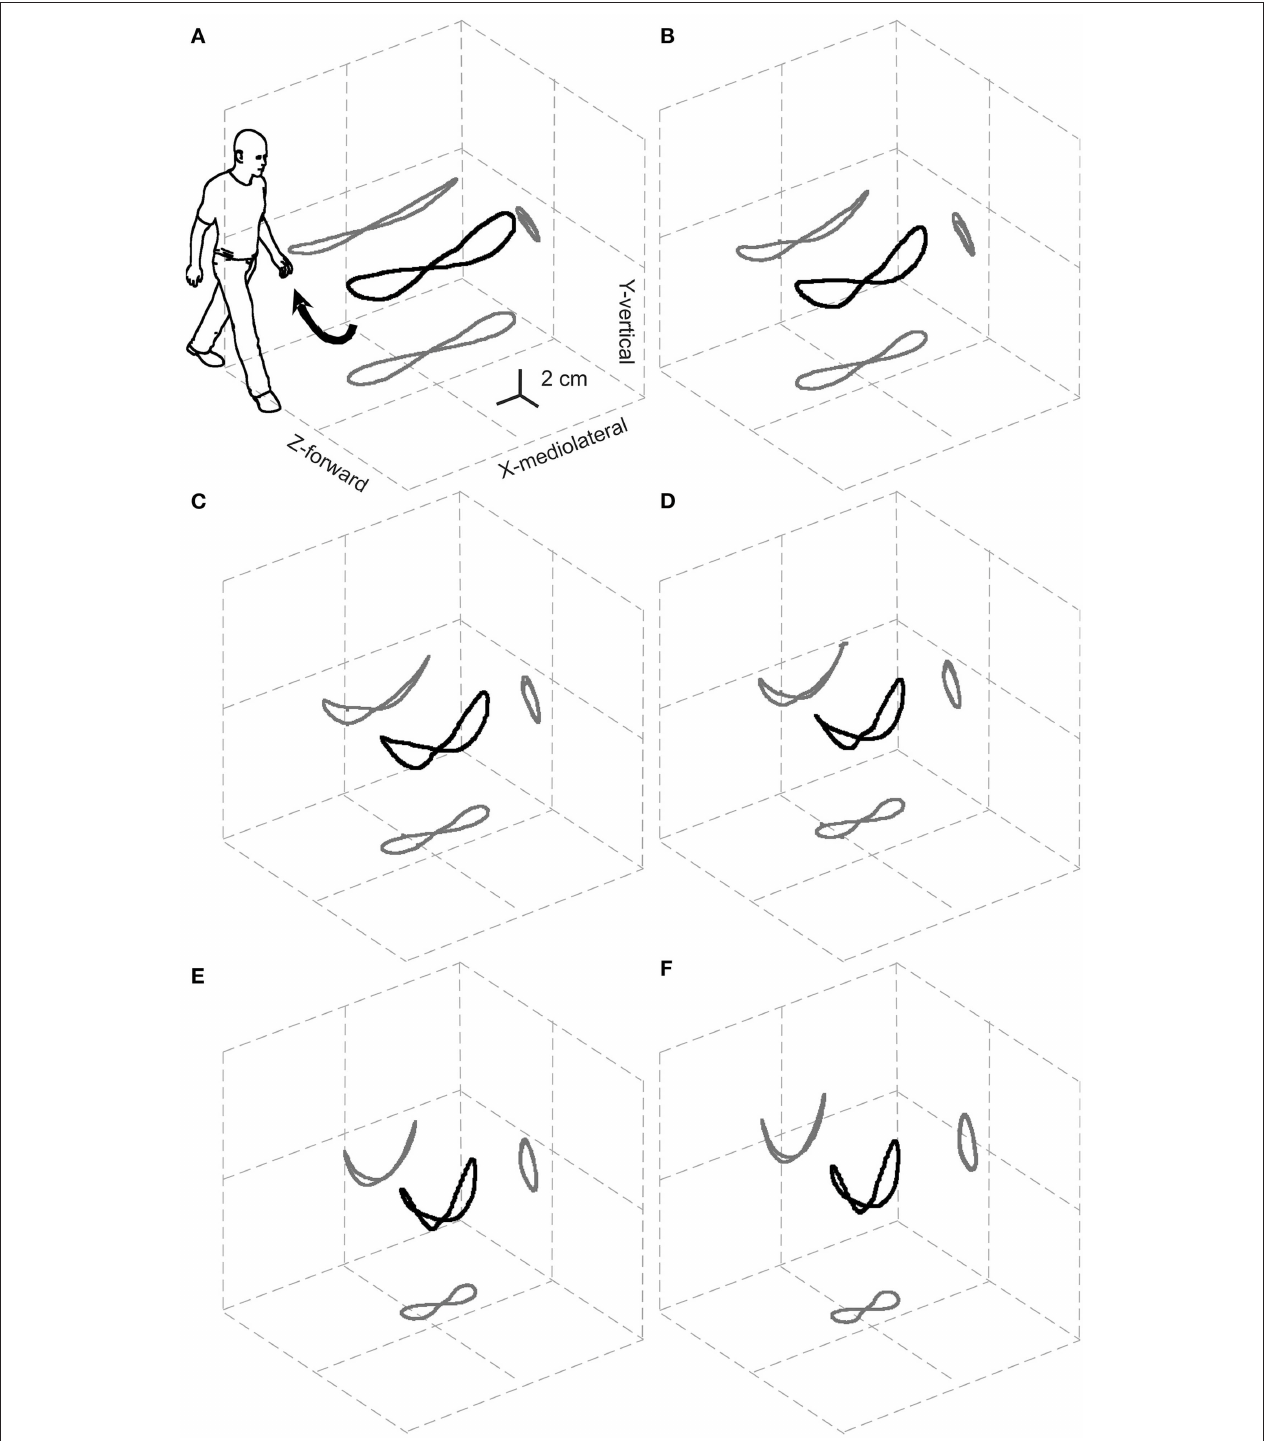
FIGURE 2 | Relationships between the 3D path of the center of mass (CoM) during one stride and the walking speed. The black and gray curves represent the 3D path of the CoM and their planar projections, respectively, once the displacement due to the forward velocity has been subtracted. Results are grand-averaged across 18 subjects. The resulting elegant figure is dubbed the “bow-tie.” The range of speeds tested, illustrated in (A–F) , was partitioned into increasing sextiles from 0.01 to 0.27 a-dimensional, leg length adjusted Froude units (0.3–1.4m s − 1 ). Taken from Tesio et al. (21), used with permission.